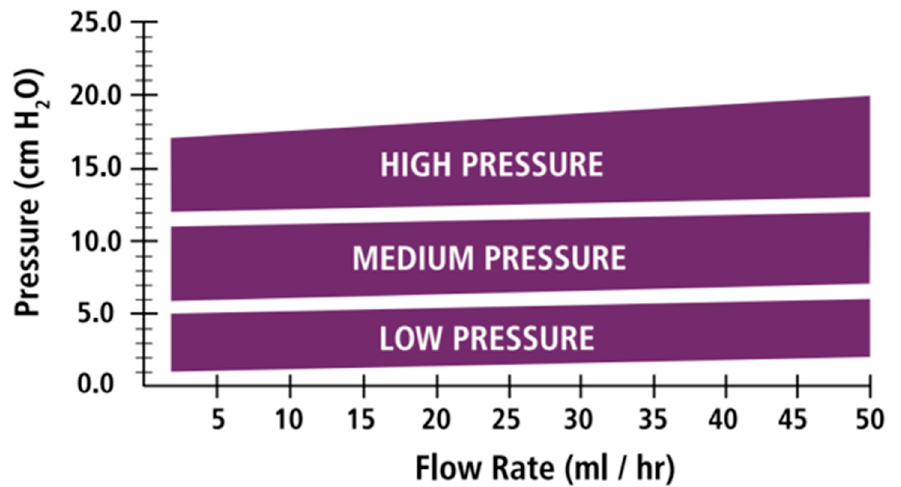
Figure 4. Figure reproduced with permission from the Natus Neurosurgery and Neurocritical Care Product and Accessory Catalog, 2019 (https://natus.com, accessed on 23 June 2020). In this graph, the flow–pressure data for the Contour-Flex™ family of valves are shown. Contour-Flex™ are typical silicone diaphragm valves with a low–medium- and high-pressure ranges. Flow rates in the x-axis represent a variable flow rate from 1 to 50 mL/h while in the y-axis the pressure generated at each flow rate is shown. Colored bands define the variability of the pressures obtained for each flow